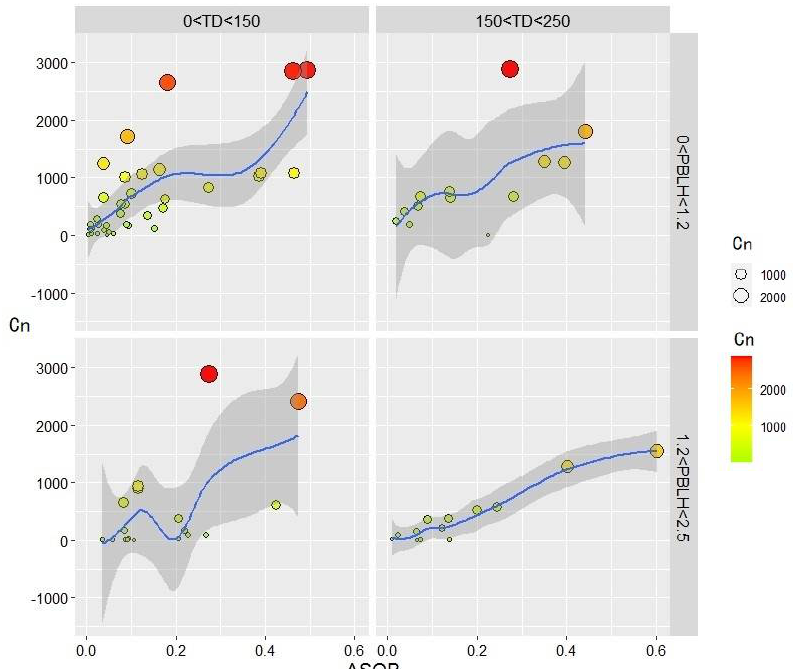
Figure 13. Relationships between burning area and PM 2.5−inflow concentration fitted under four combinatorial conditions of transport distance and average PBLH along the transport pathway. Note: ASOB, TD, and PBLH in the figure represent area of SOB (ha), transport distance (km), and PBLH along the transport pathway (km). C n is the corresponding PM 2.5−inflow concentration (μg m −3 ).